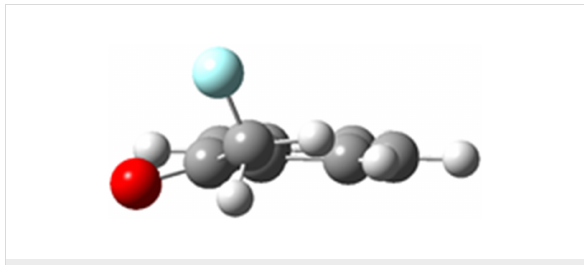
Figure 7: Highest energy conformation of fluoroacetophenone, em- phasizing the closeness of approach of fluorine atom to carbonyl π